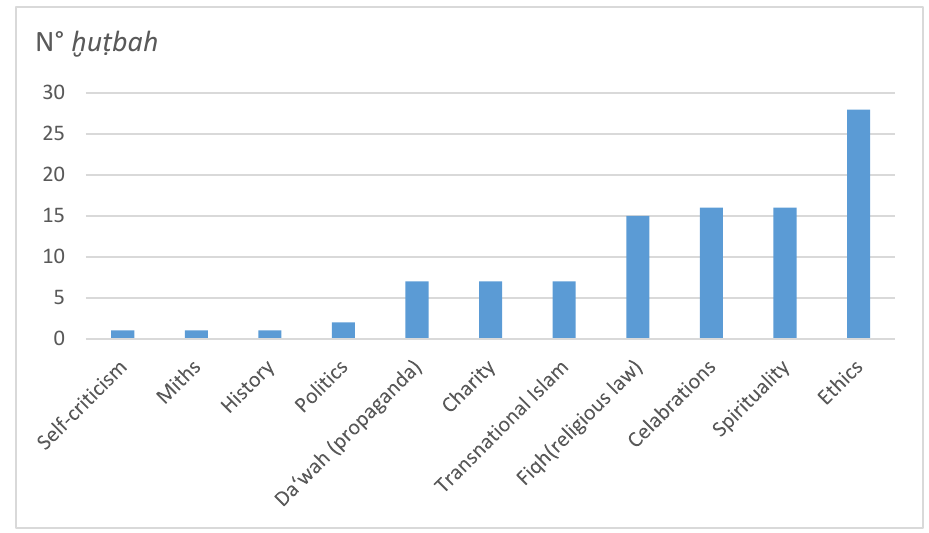
Figure 1. Theme area of the ḫ u ṭ bah . Table 1. Theme area by number of sermon.